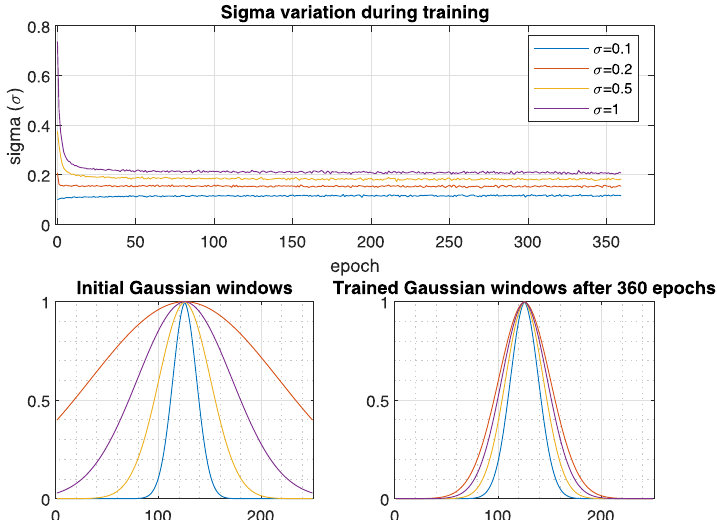
Fig. 2 Convergence of trainable parameter σ and the corresponding Gaussian window functions when initialized to different values during training runs